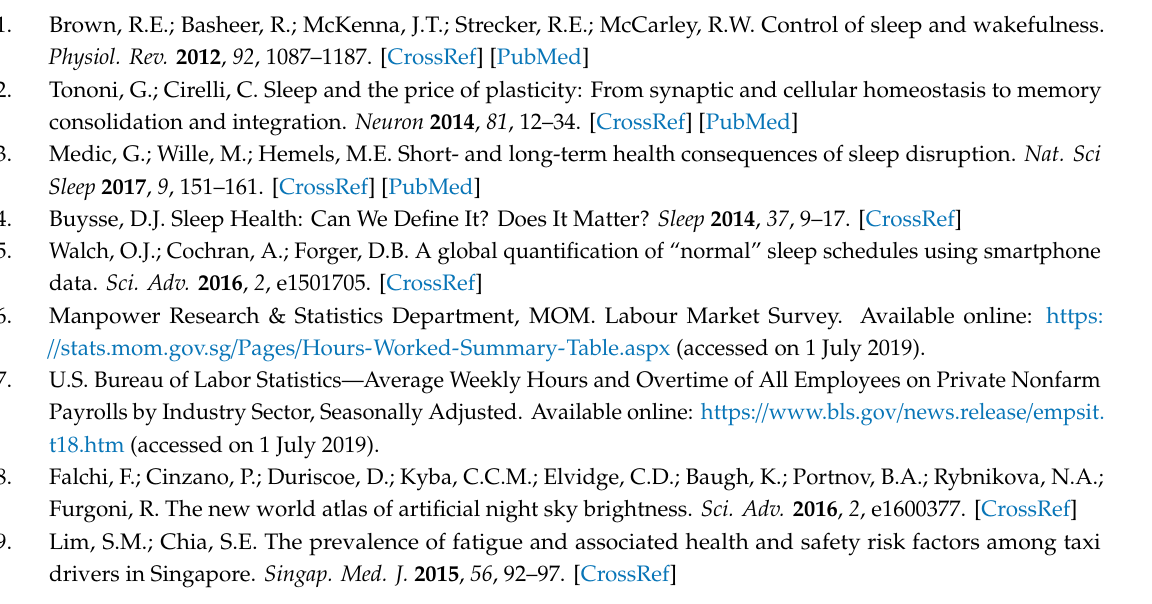
Table S1: Characteristics of study participants (Health, lifestyle and occupational factors), Table S2: Univariate associations with Physical Component Summary (PCS) and Mental Component Summary (MCS), Table S3: Multivariable analysis for objective sleep parameters and Physical Component Summary, Table S4: Multivariable analysis for subjective sleep parameters and Physical Component Summary, Table S5: Multivariable analysis for objective sleep parameters and Mental Component Summary, Table S6: Multivariable analysis for subjective sleep parameters and Mental Component